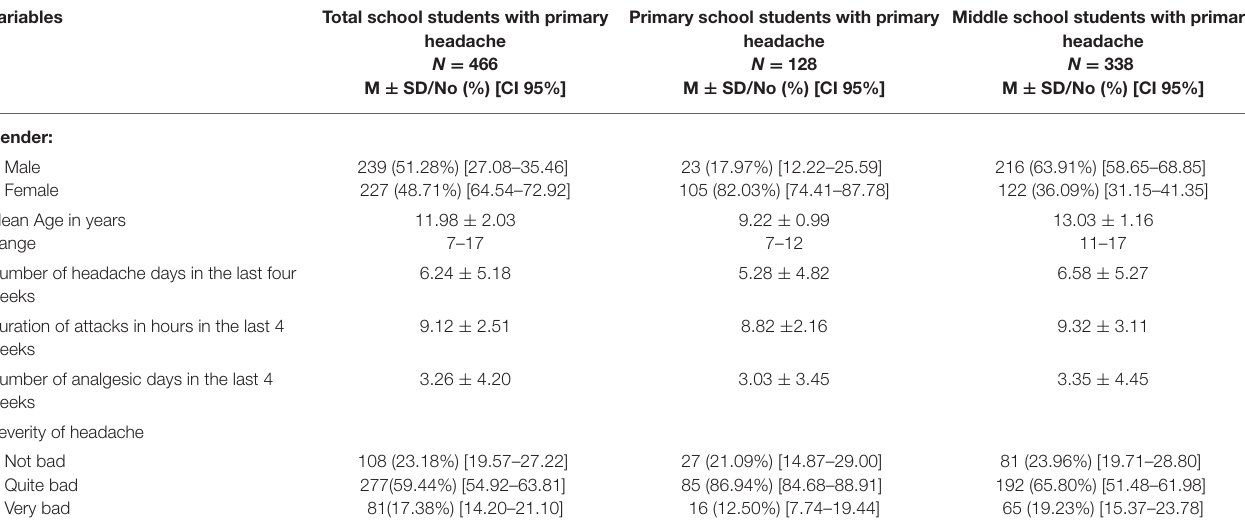
TABLE 2 | Characteristics of Primary Headache among school children with Primary Headache Disorders (No = 466).